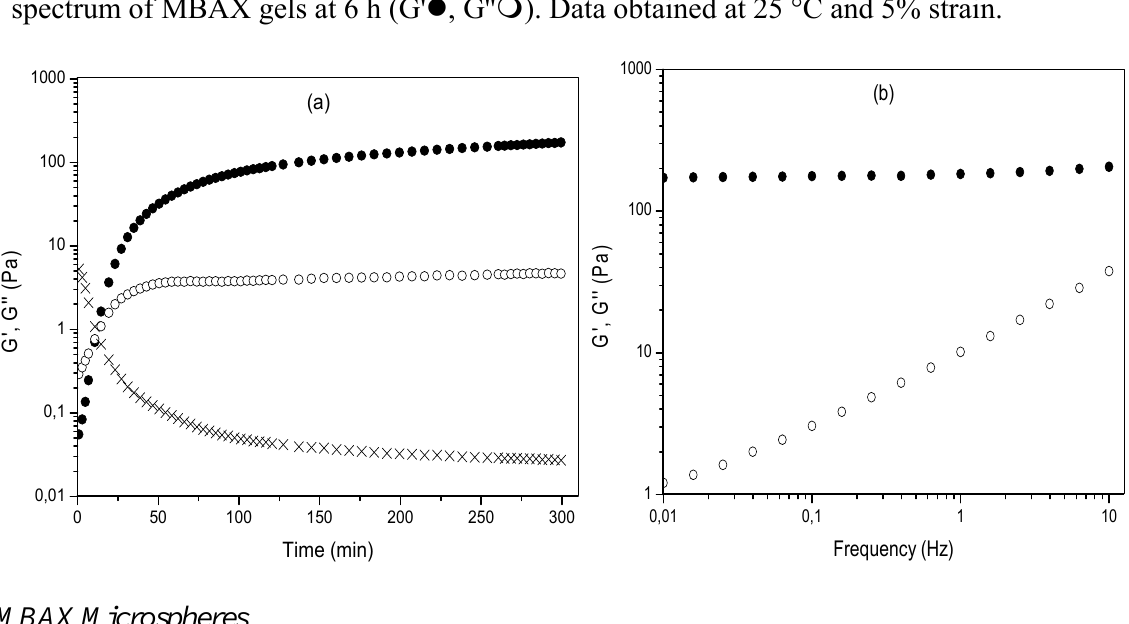
solution during gelation by laccase at 25 °C, 0.25 Hz and 5% strain; ( b ) Mechanical spectrum of MBAX gels at 6 h (G'  , G''  ). Data obtained at 25 °C and 5%